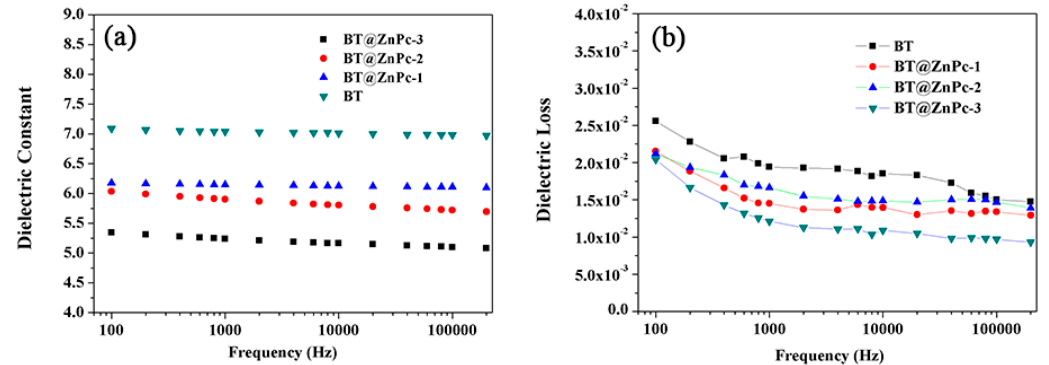
Figure 5. Dielectric constant ( a ) and dielectric loss ( b ) of PEN composites with 30 wt% of BT,